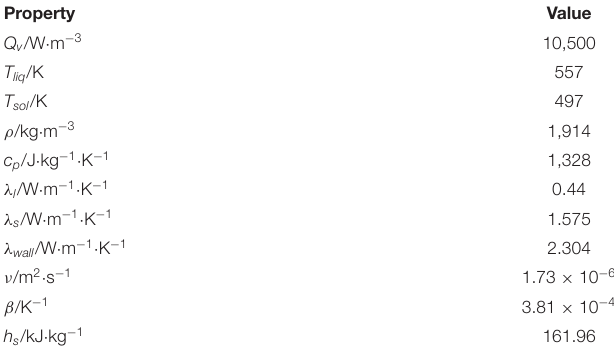
TABLE 1 | Main properties of COPRA